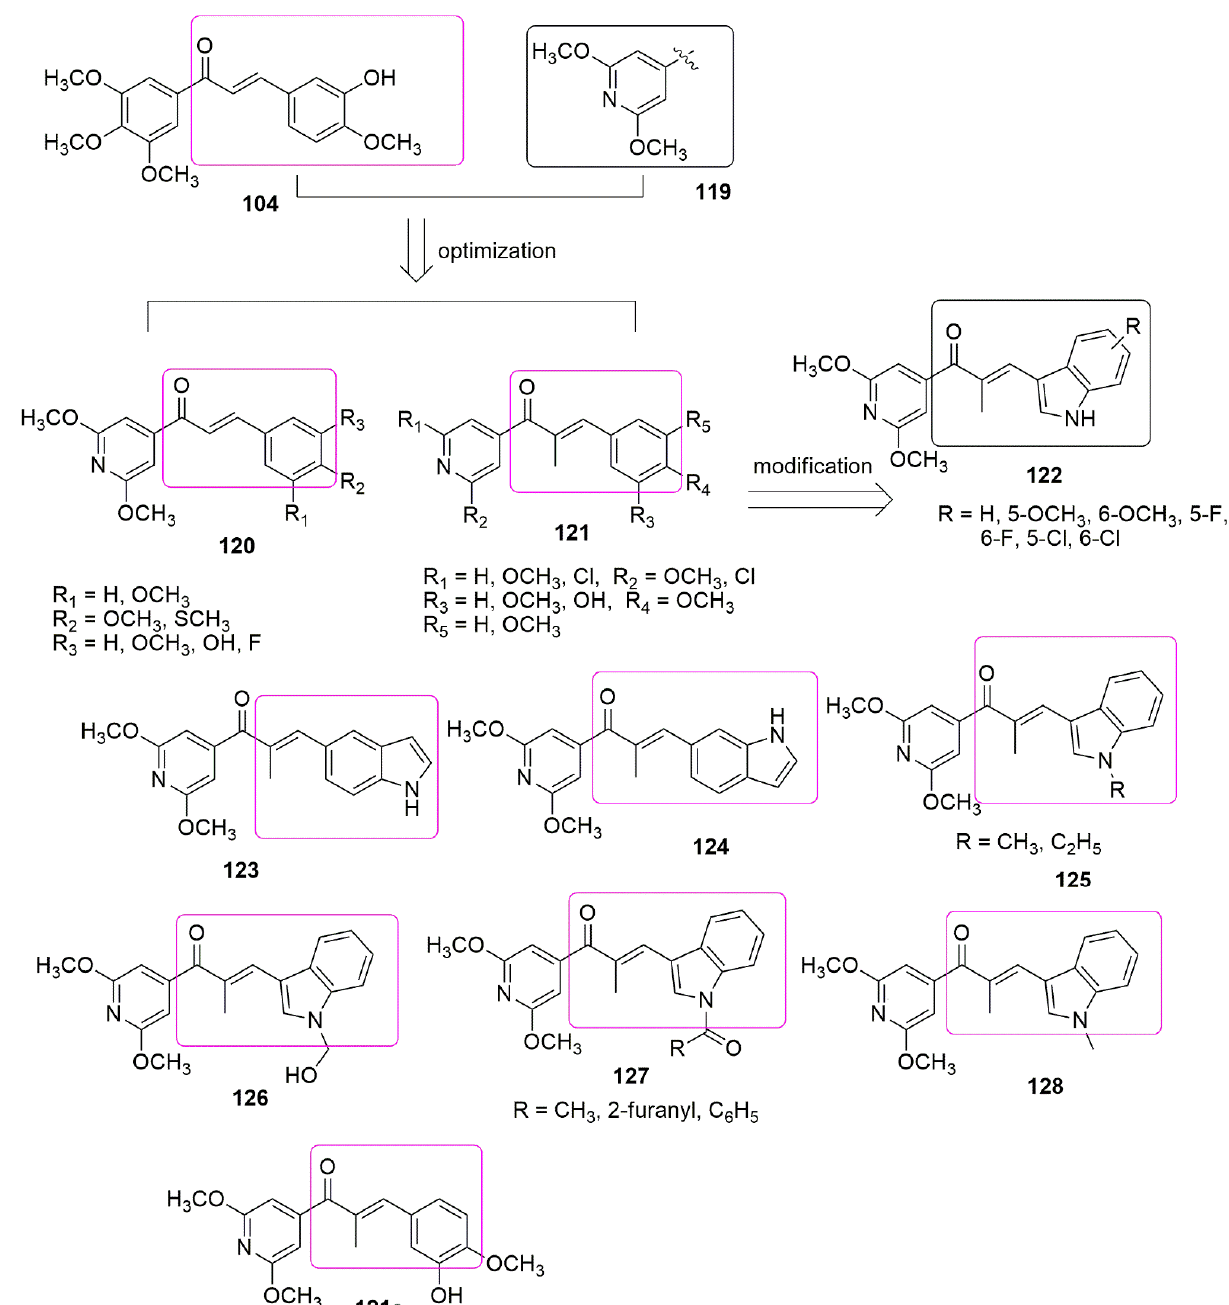
Figure 35. Chemical structures of pyridine-chalcone derivatives. The broad-spectrum activity of sarcodictyin A 129a , and sarcodictyin B 129b , a natu- ral compound with anti-tubulin activity, have impelled many medicinal chemists to ex- plore the total synthesis and subsequently derivatization. In addition, the α , β –unsatu- rated hetero-aromatic structure and the imidazole ring are both responsible for the com- pound’s strong activity thus the substitution of imidazole with another heterocycle group will disfavor the activity of the compounds. Hence, Oskuei et al.[102] designed and syn- thesized a new series of imidazole-chalcone conjugates 130 as anti-tubulin and anti-cancer